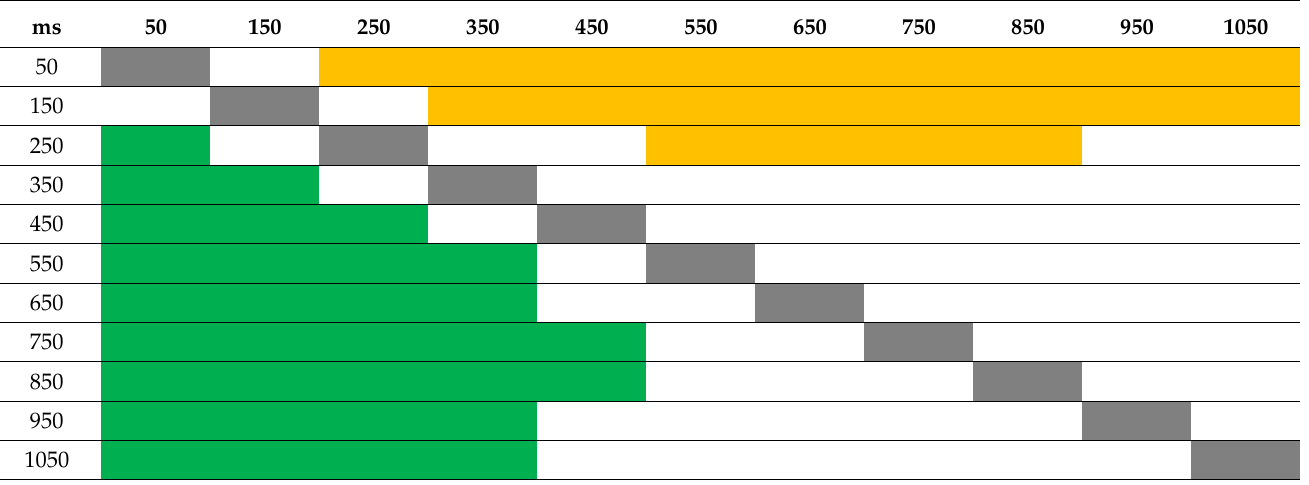
diagonal fields.